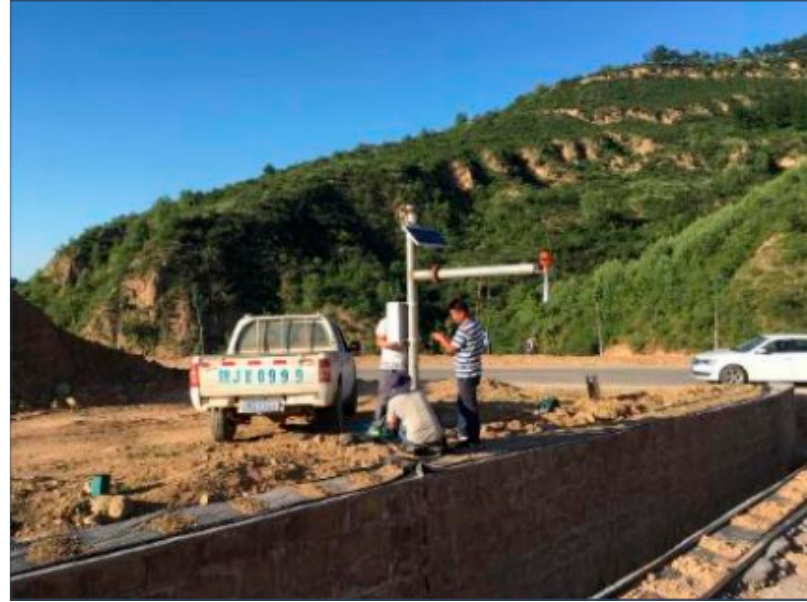
Figure 4. The auto-recording tipping bucket rain gauge and radar water level sensor at watershed outlet.